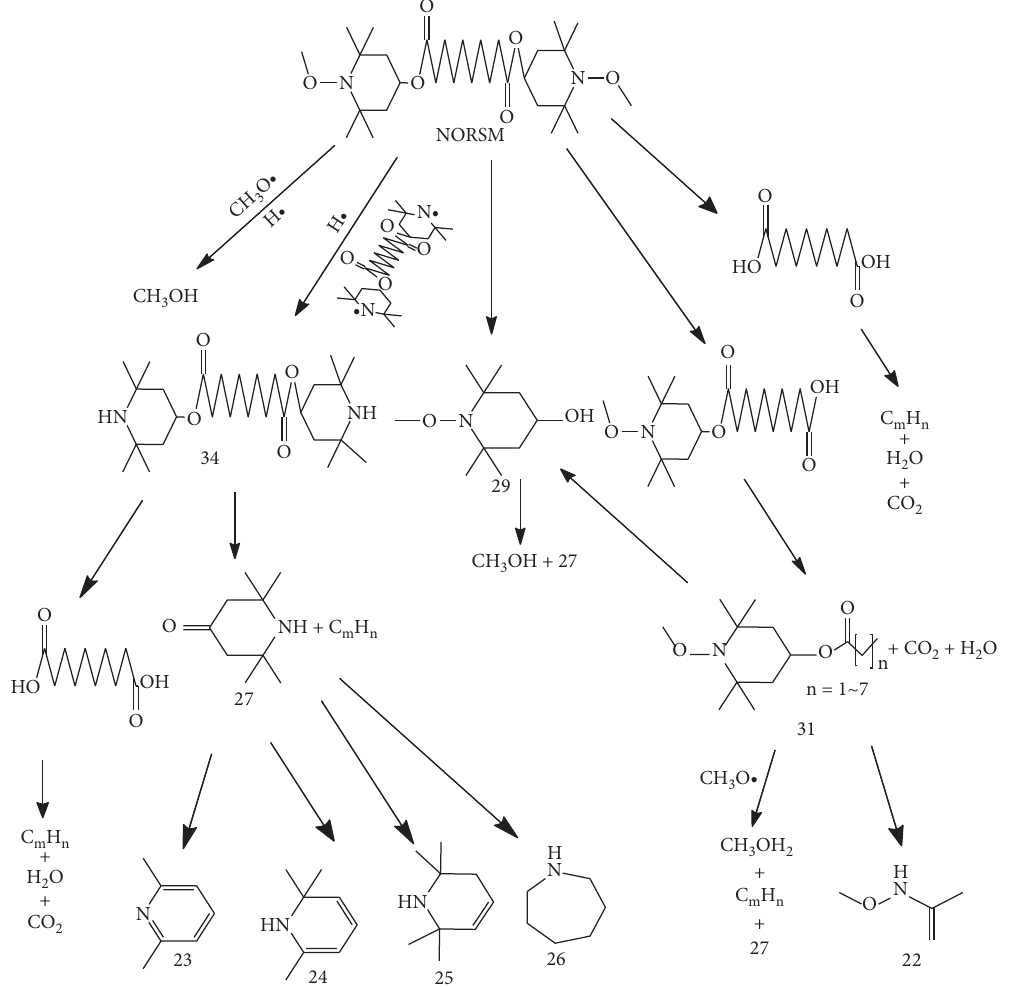
Scheme 3: Possible decomposition route of NORSM.